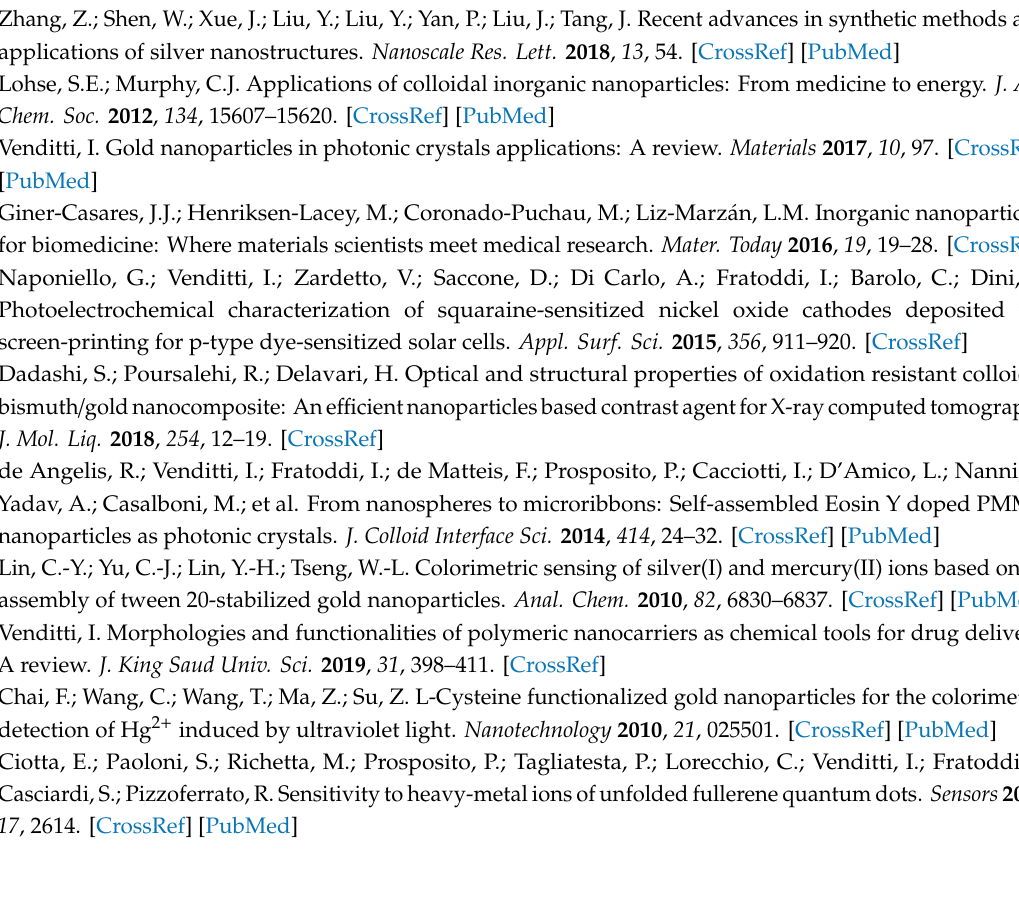
Figure S1. TEM images of AgNPs; Figure S2. L-Cys FTIR spectrum; Figure S3. Uv-Vis spectra of of AgNPs in presence of 2.5 ppm of metal ions (As 3 + , As 5 + , Ca 2 + , Co 2 + , Mg 2 + , Nd 3 + , Ni 2 + , Zn 2 + , Pb 2 + ) in water; all references curves (AgNPs alone) are in black line, while red curves represent the interaction between AgNPs and metal ions; Table S1. Table XPS. BE, FWHM, Atomic Ratio values and proposed assignments for all measured core-level signals